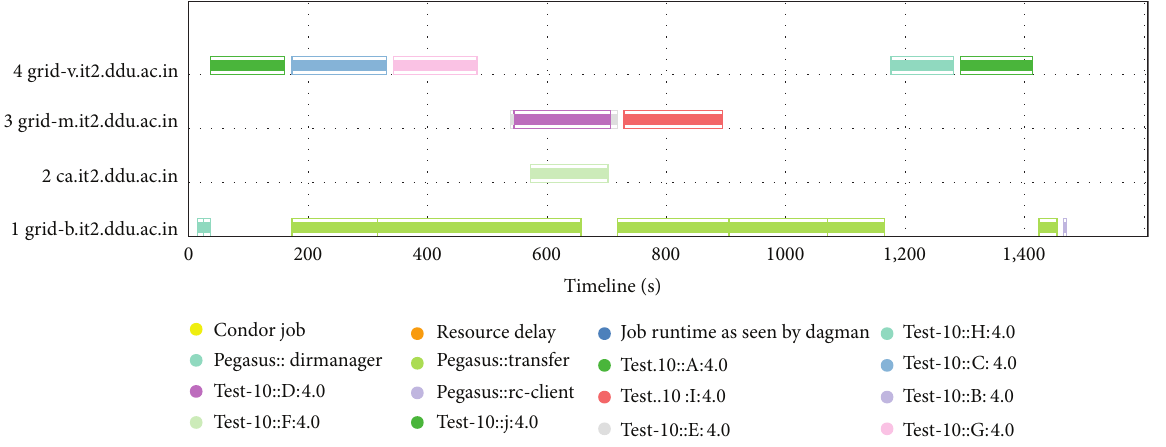
Figure 3: The output schedule for the workflow of 10 tasks scheduled using Heft site-selector provided by Pegasus WMS.